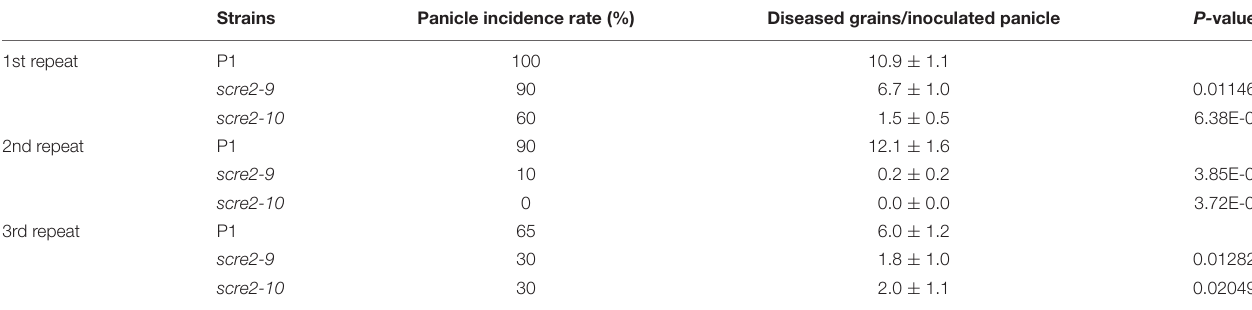
TABLE 1 | The disease index in rice panicles after U. virens artificial inoculation. Strains Panicle incidence rate (%) Diseased grains/inoculated